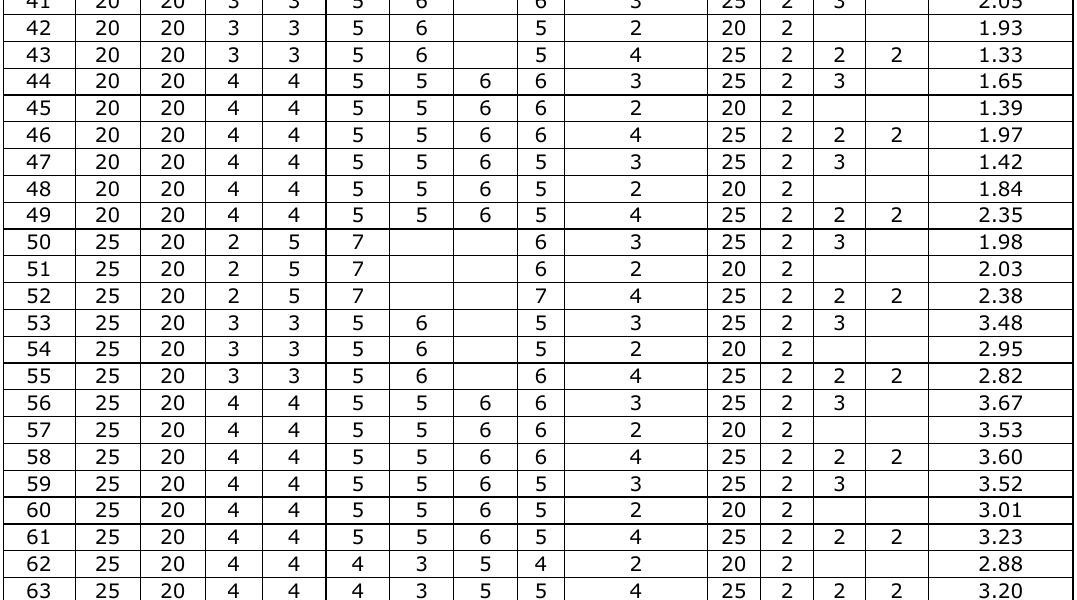
Table 5. “Factors used to generate each instance”. Source: